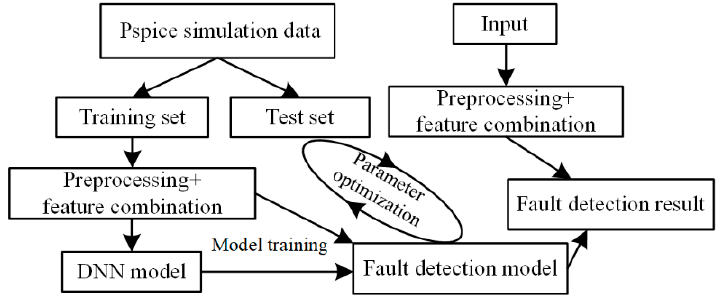
Figure 4. Fault detection process based on deep learning.